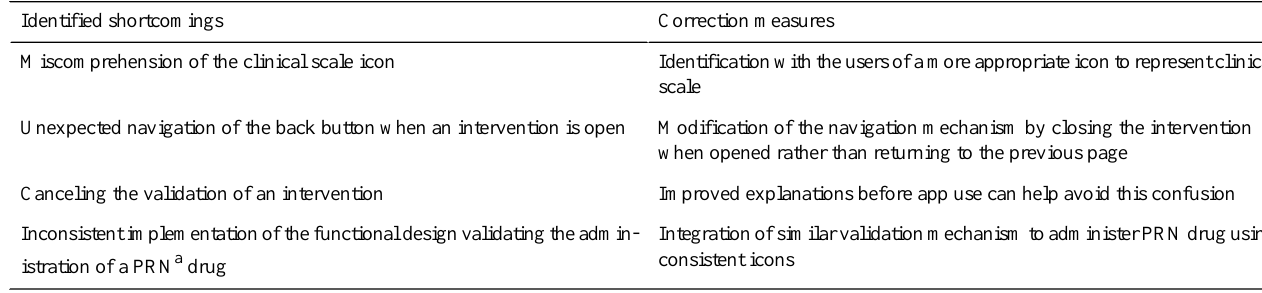
Table 4. Identified shortcomings and correction measures.